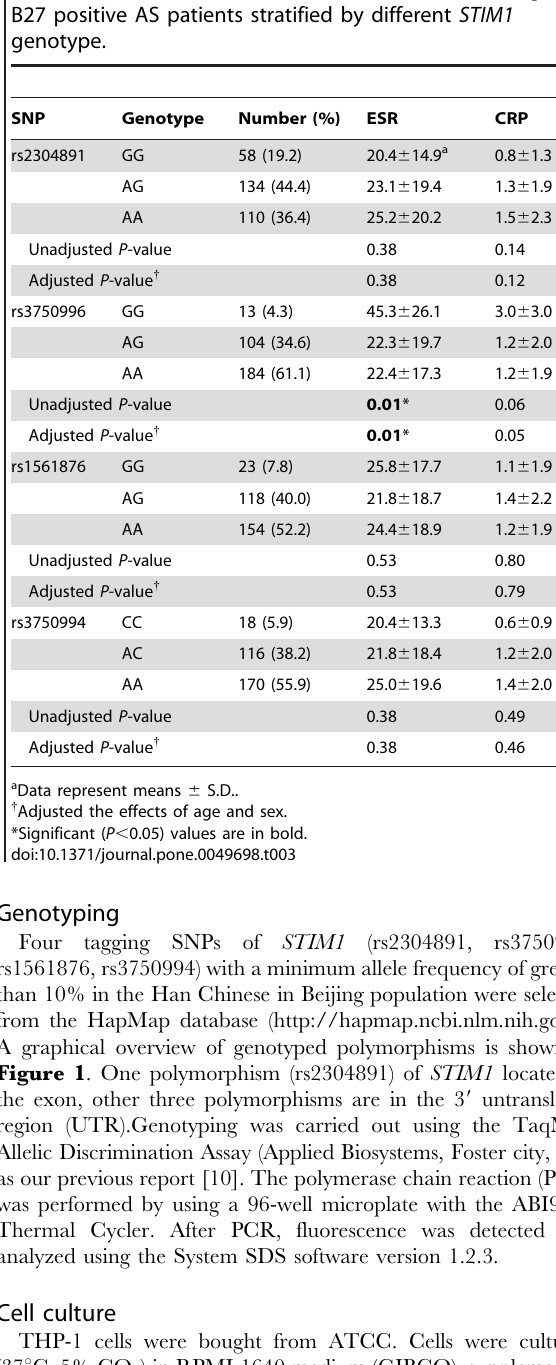
of TNF- a were forward primer: 5 9 -GACAAGCCTGTAGCC- CATGTTGTA-3 9 and reverse primer: 5 9 -CAGCCTTGG- CCCTTGAAGA-3 9 . Each well contained the following reaction